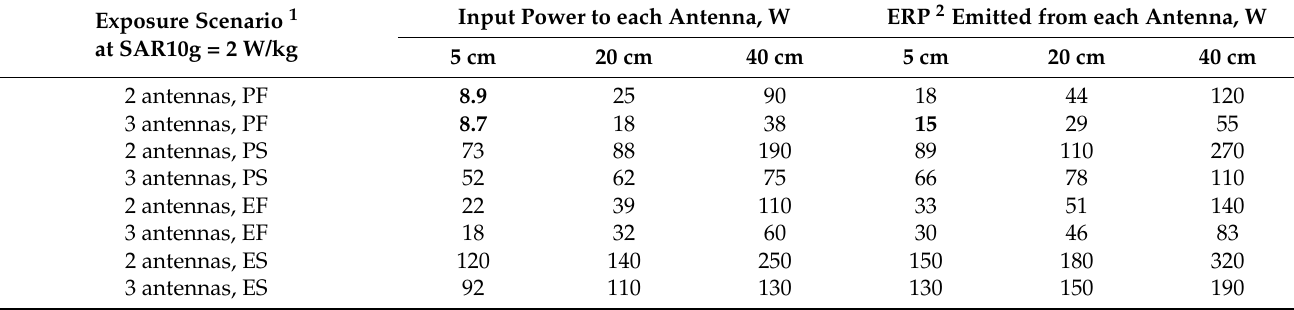
Table 4. The level of EMF emission from UHF I-RFID readers at 866 MHz, causing SAR10g values in the human body model Duke equal to the general public limits in the considered exposure scenarios (maximum local SAR averaged over a 10 g